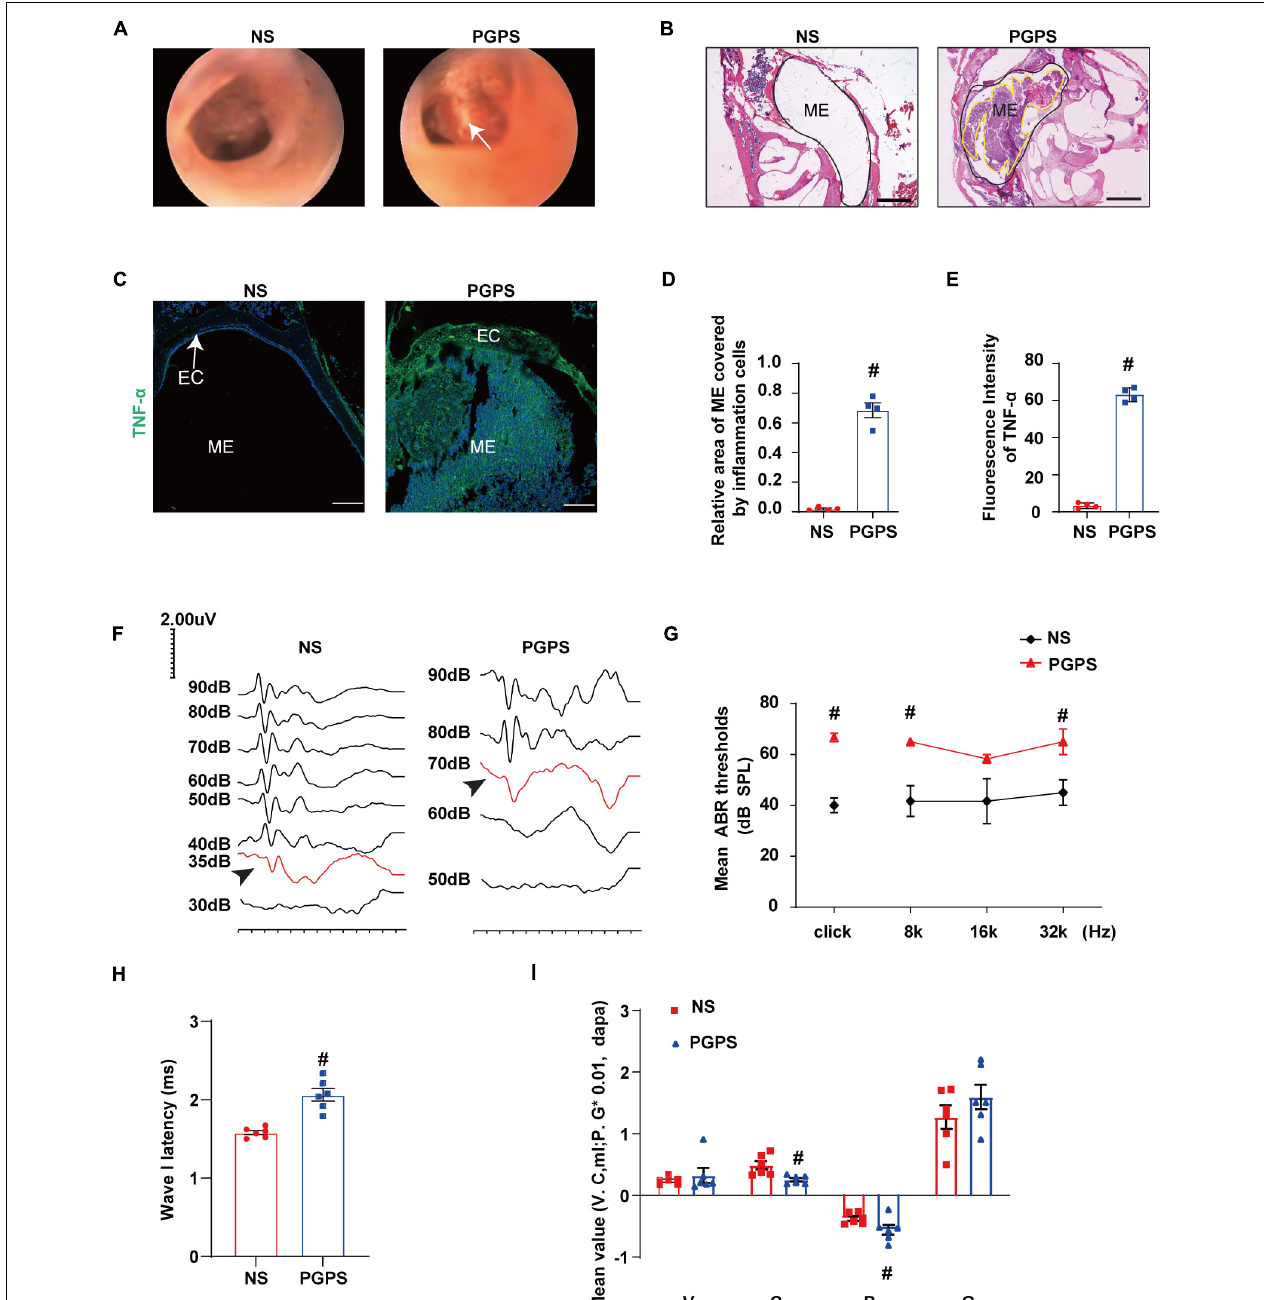
FIGURE 1 | Inoculation with PGPS induces ME inflammation and hearing loss. (A) Otoscopic images of ears from the NS and PGPS groups are shown. Hyperemia and hydrotympanum (white arrow) were detected in PGPS group. (B) H&E histology showing the structures and pathology of the ME. (C) Mice were inoculated with NS or PGPS for 3 days. Representative immunostaining for TNF- α expression in ME. (D) Quantification of the relative area of ME covered by inflammatory cells is shown in the bar graph. n = 4 per group (E) Quantification of the fluorescence intensity of TNF- α is shown in the bar graph. n = 4 per group (F) Representative images of ABR waveforms at click stimuli are shown. The red lines and arrowheads represent threshold waveforms. (G) Mice were inoculated with PGPS for 3 days, and the ABR thresholds were measured at the stimuli frequencies of click, 8 kHz, 16 kHz, and 32 kHz. The mean ABR thresholds in PGPS-injected mice were compared with those in NS-injected mice. The data is presented as the mean ± SEM. n = 10 per group (H) The latency of ABR wave I at click stimuli (80 dB SPL) in PGPS-injected mice compared with that in NS-injected mice is shown. Horizontal bars are mean values. n = 10 per group. (I) The tympanometry values in PGPS-injected mice compared with those in NS-injected mice are shown. The data are presented as the mean ± SEM. n = 10 per group. V represents the mean value of volume, C represents compliance in tympanometry parameters, G represents the gradient, and P represents the pressure. # P < 0.05 vs. NS group, Student’s t -test. Scales bar, 100 µ m (B,C)